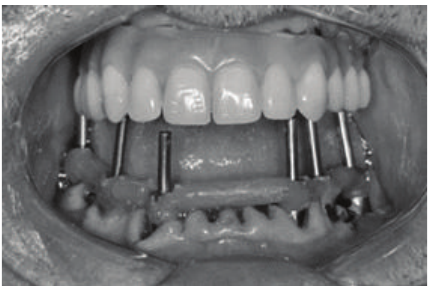
Figure 1: Initial aspect of the patient before treatment.